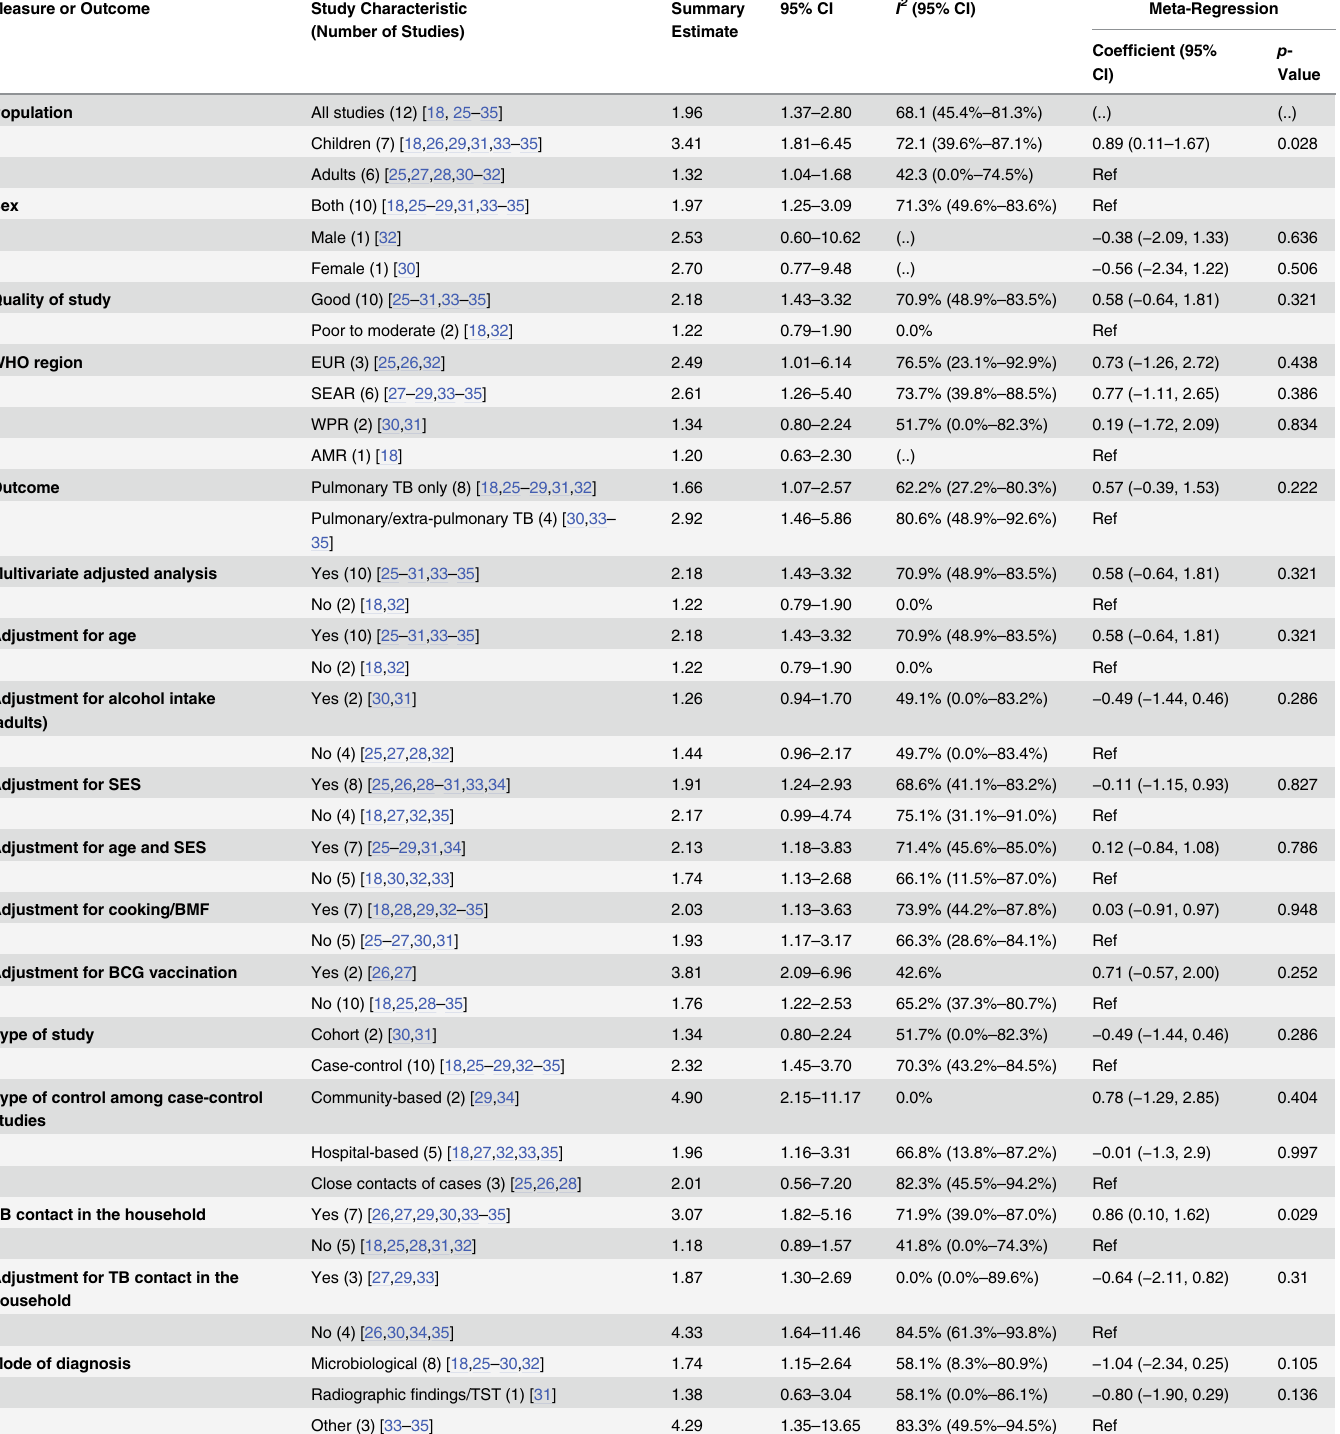
Table 3. Quality assessment and subgroup analysis: second-hand smoke exposure and active TB